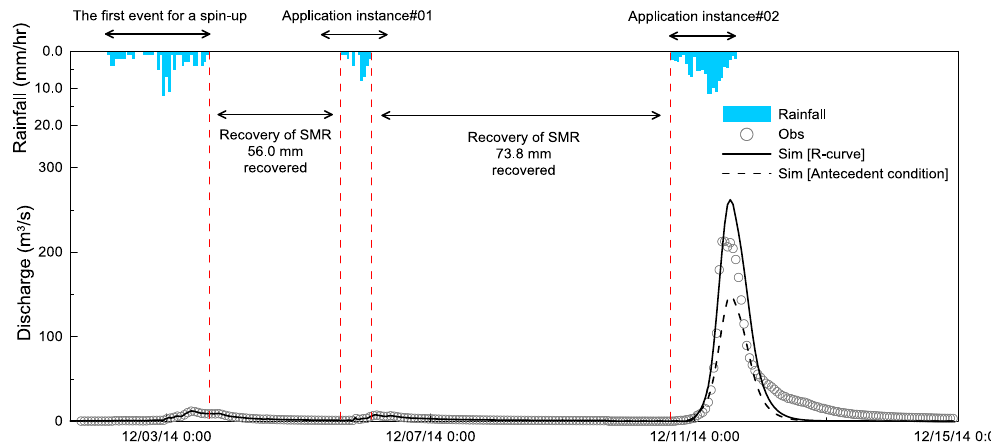
Figure 14. Rainfall-runoff simulation results: In this figure, ‘obs’ indicates observed streamflow, ‘Sim [R-curve]’ indicates a simulation hydrograph resulting from the proposed R-curve method, and ‘Sim [Antecedent condition]’ indicates a simulation hydrograph resulting from the conventional antecedent condition method in CN method to determine the antecedent CN value.